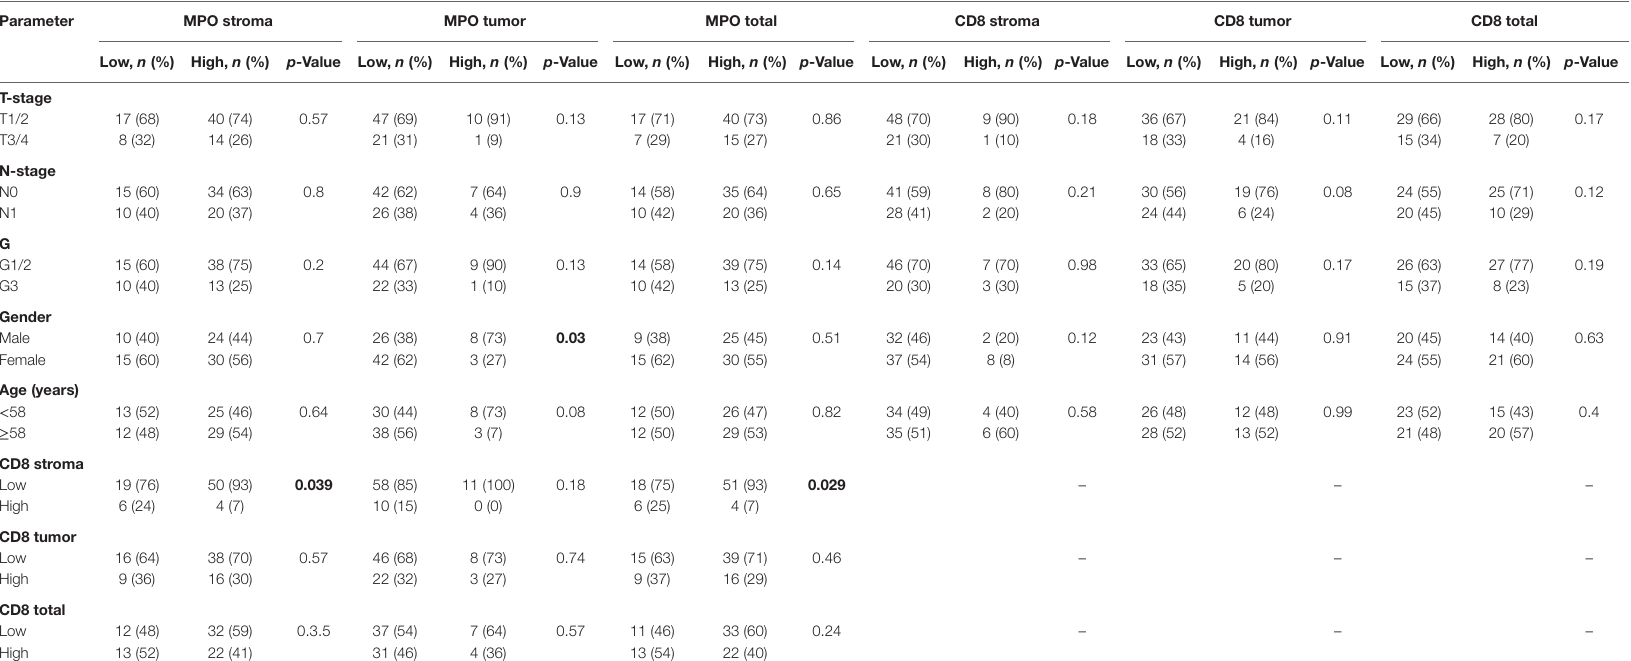
Table 2 | Correlation of clinicopathological parameters with MPO and CD8 score according to different tumor compartments. Parameter MPO stroma MPO tumor MPO total cD8 stroma cD8 tumor cD8 total low, n (%) high, n (%) p -Value low, n (%) high, n (%) p -Value low, n (%) high, n (%) p -Value low, n (%) high, n (%) p -Value low, n (%) high, n (%) p -Value low, n (%) high, n (%) p -Value T-stage T1/2 n-stage N0 g G1/2 gender Male age (years) <